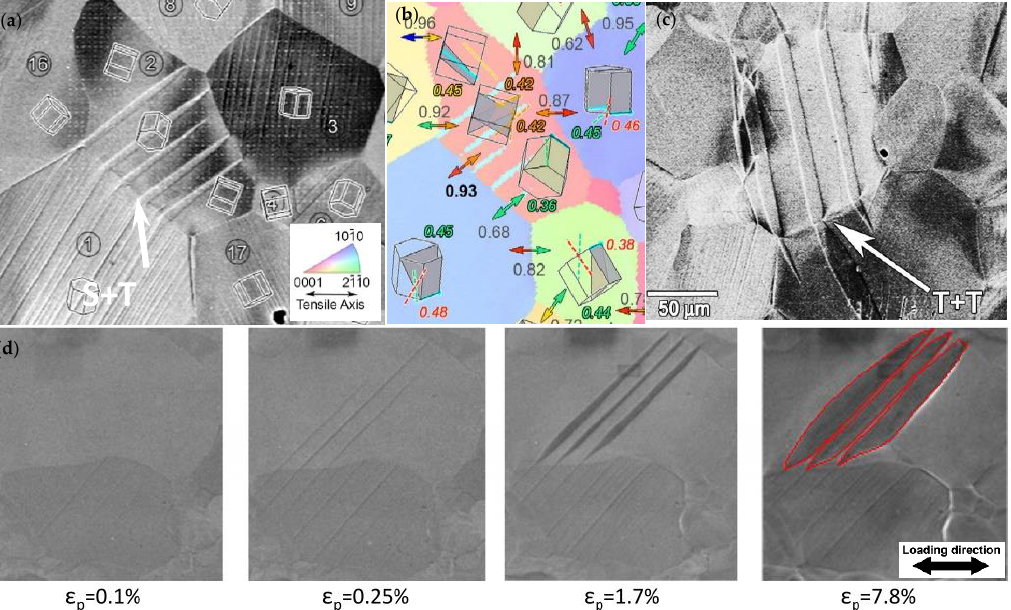
Figure 8. ( a ) Deformation twins in grain 2 nucleated at the grain boundary with grain 1; ( b ) IPF of a part of grains in ( a ); ( c ) slip and twin transfer induced twinning [86]; ( d ) in situ observation of the twinning process induced by slip transfer [93].